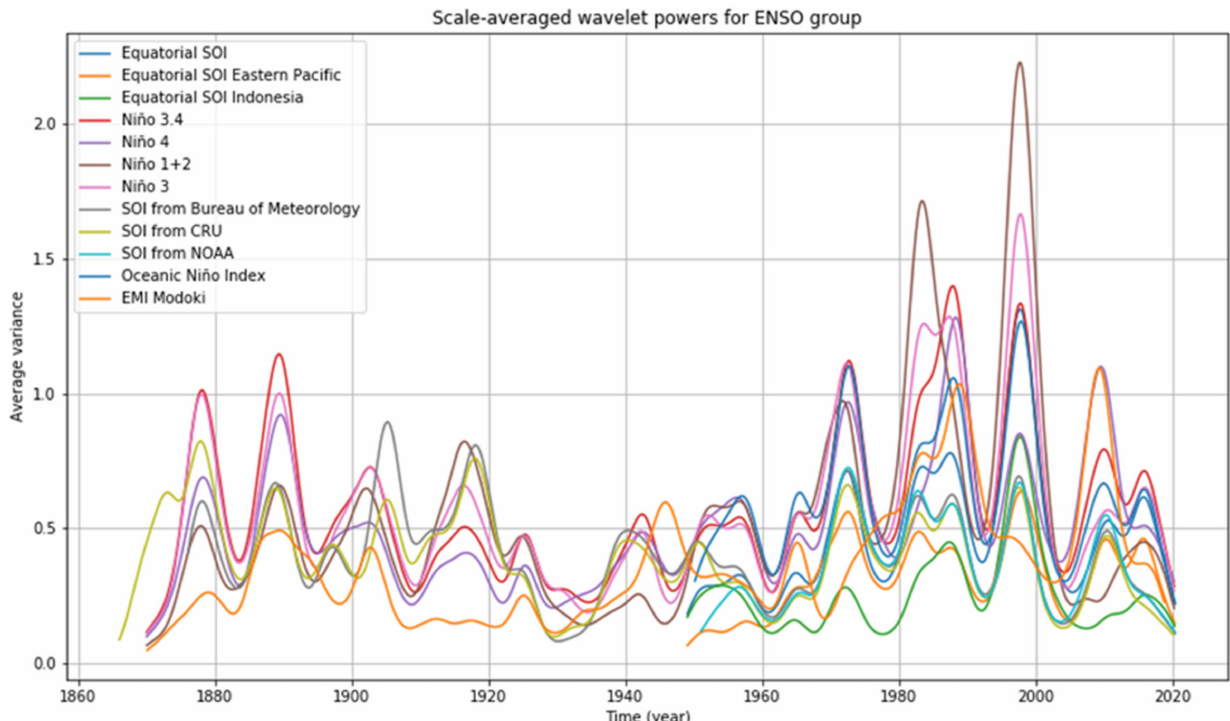
Figure 10. Scale-averaged wavelet powers of indices in ENSO-related indices. Note various intervals of data availability as per Table